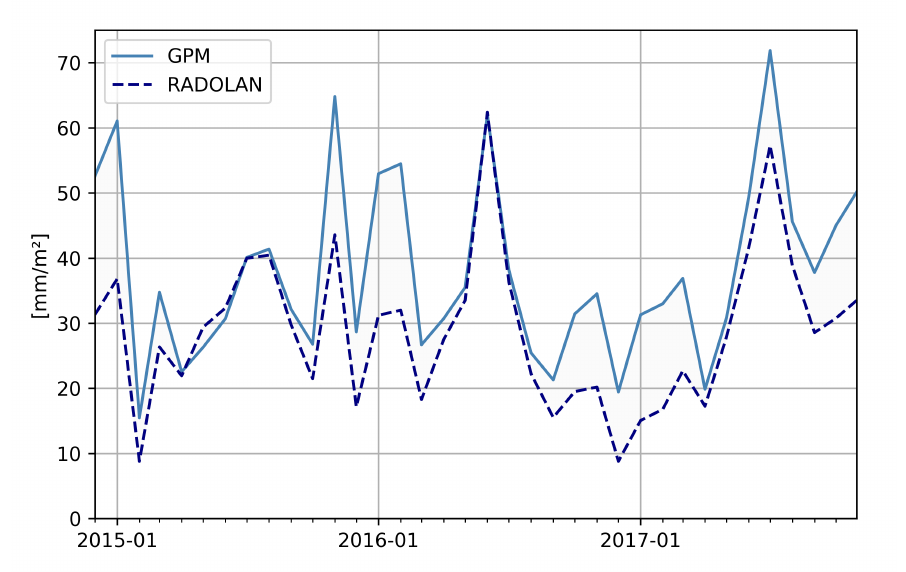
Figure 3. Spatially-averaged monthly precipitation sums in the GPM and RADOLAN